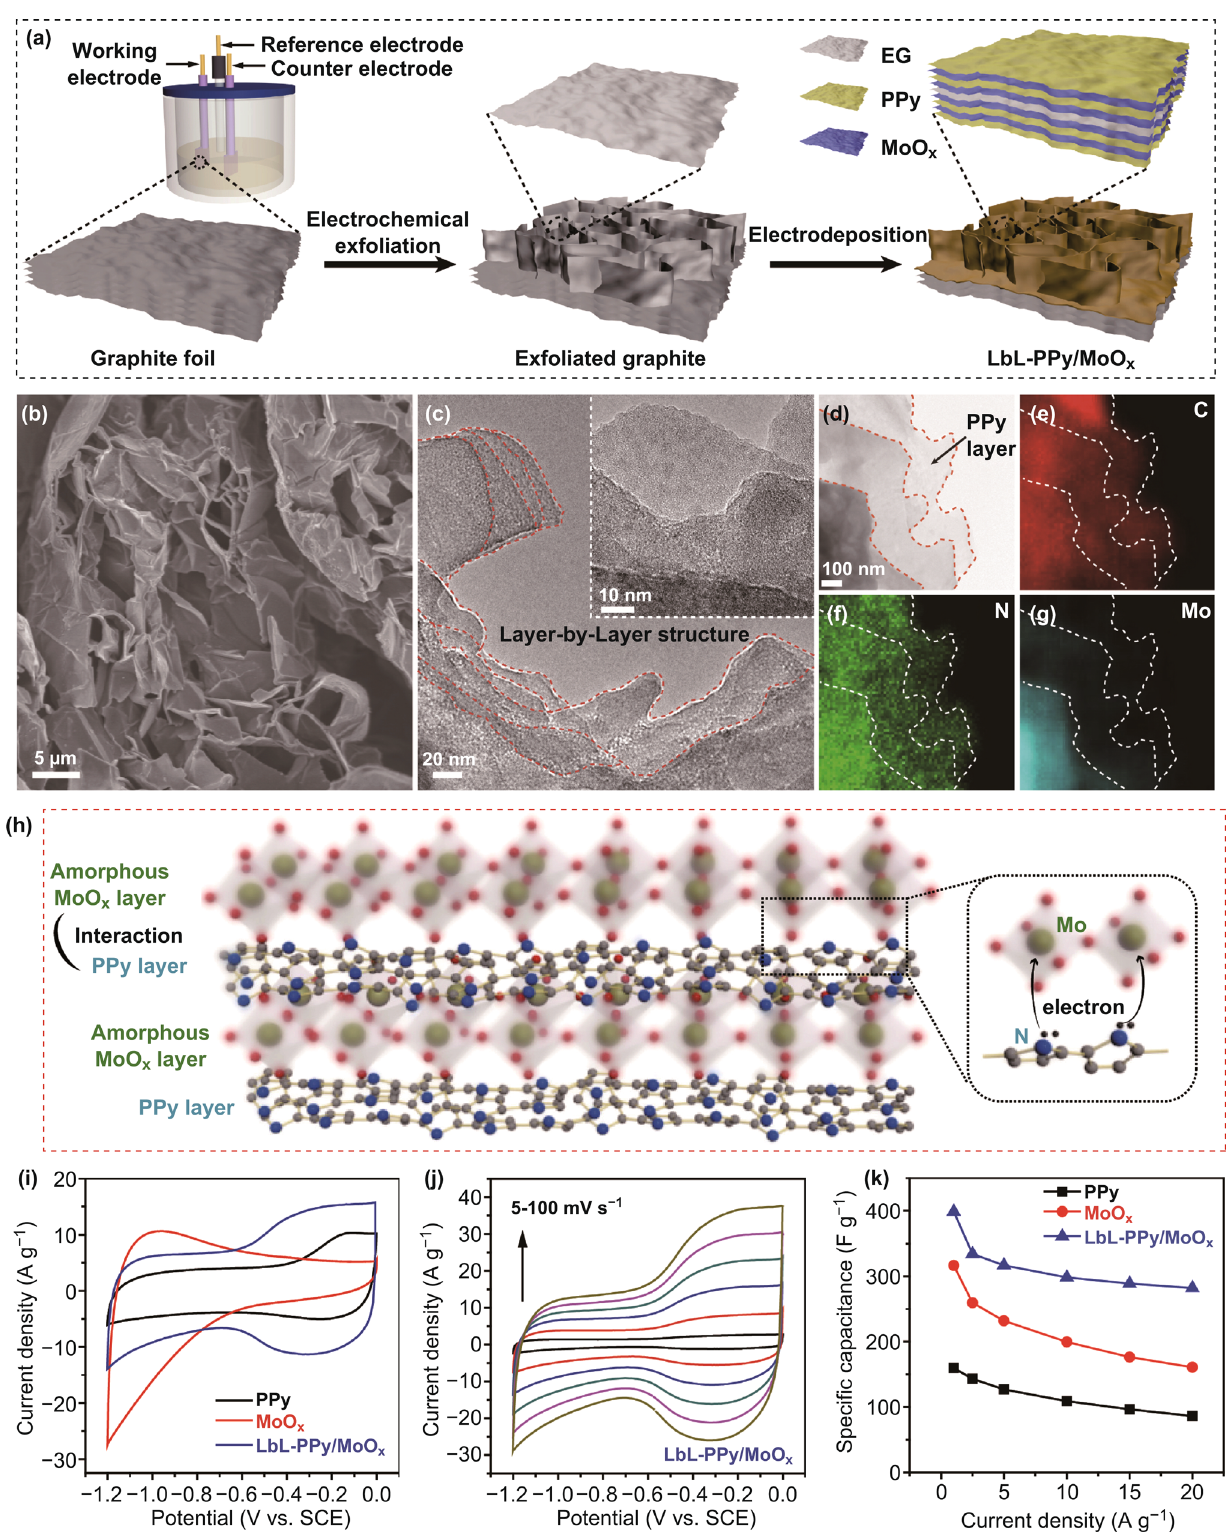
Fig. 30 a Schemes of the synthesis steps, b SEM image, c TEM image, and d‑g elemental mappings of layer‑by‑layer PPy/MoO x . h Interactions between PPy and MoO x layers. i CV curves of PPy, MoO x , and PPy/MoO x . j CV curves of PPy/MoO x at different scan rates. k Rate capability of PPy, MoO x , and PPy/MoO x . Repro‑ duced from Ref. [285] with